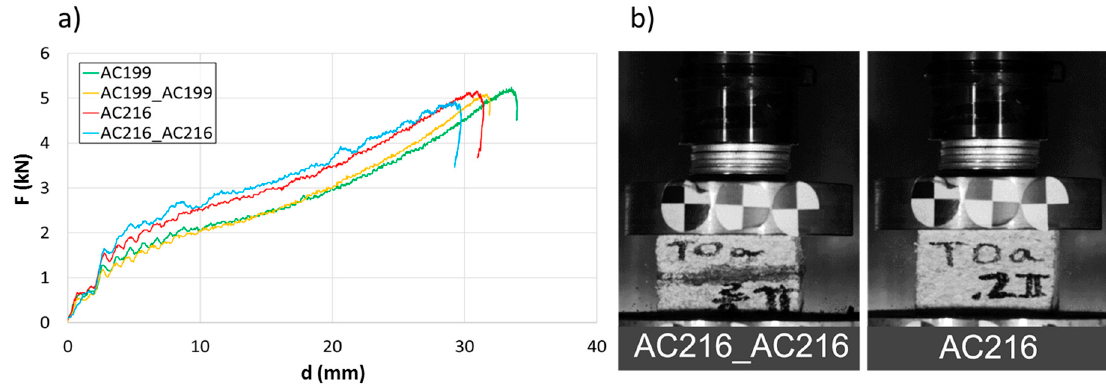
Figure 6. Comparison of mono-material agglomerate and sandwich behavior ( a ) force-deflection curves ( b ) crushing behavior at t = 10 ms.